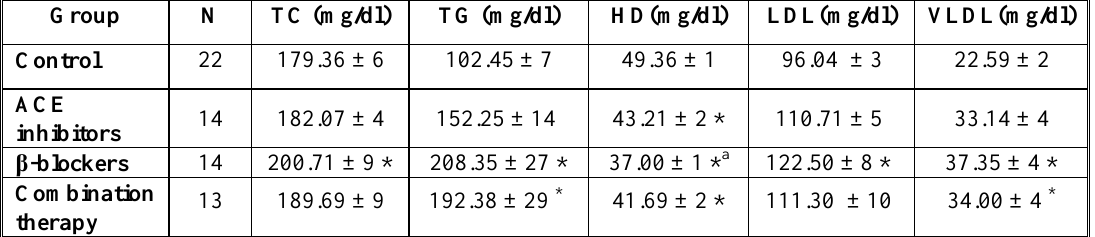
Table 4: Lipid profiles (TC, TG, HDL, LDL and VLDL) in control healthy individuals and hypertensive patients treated with different antihypertensive drug regimens. Each value represents mean± standard error of mean.